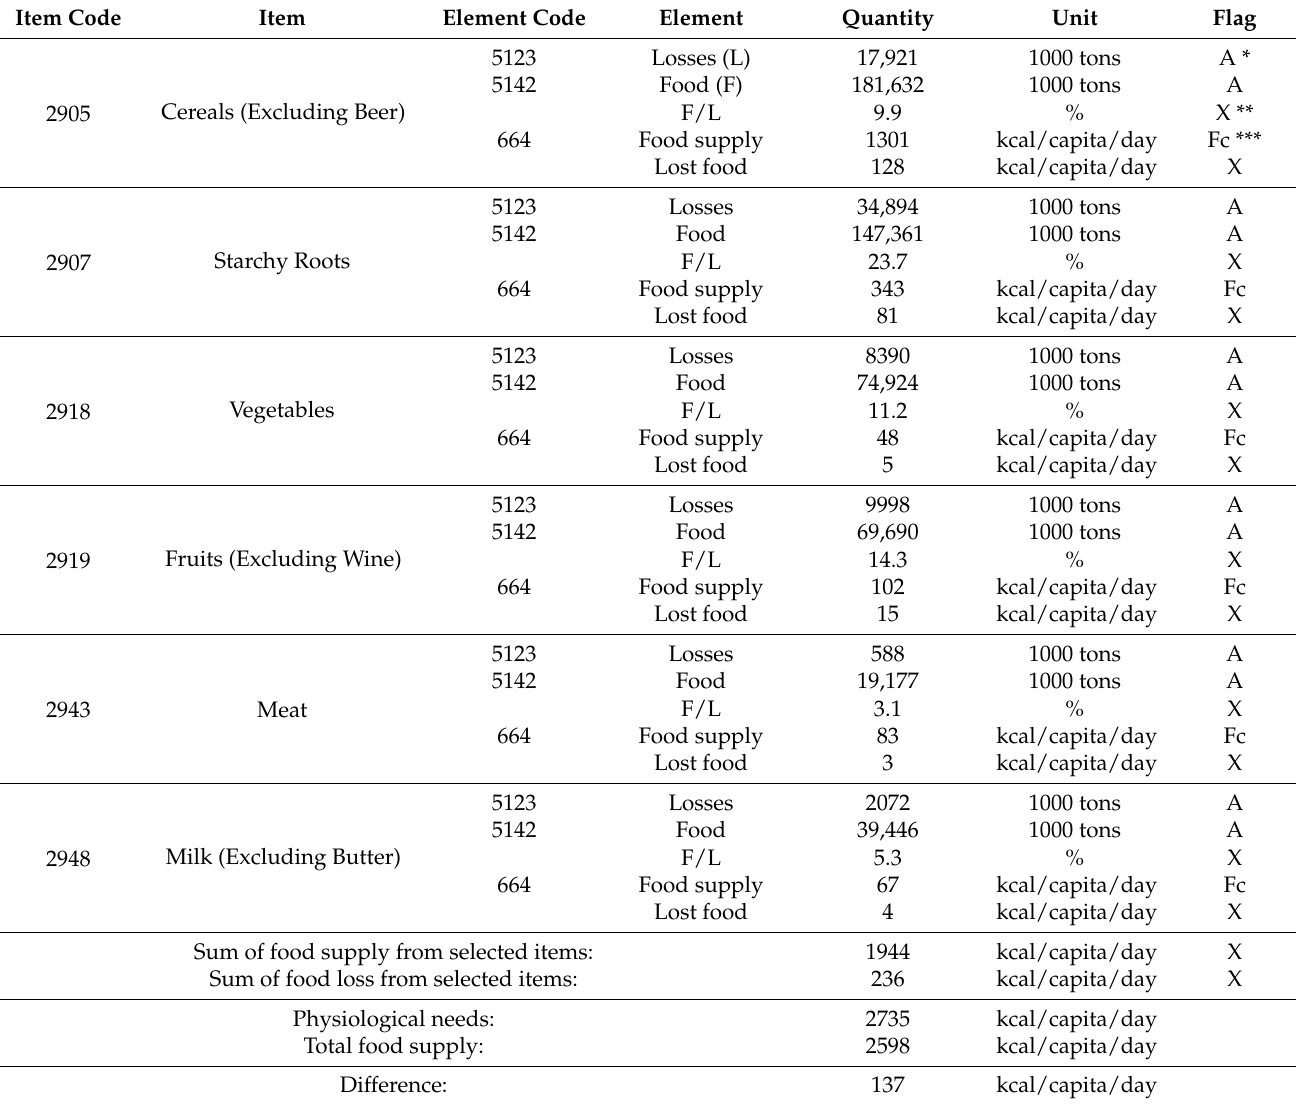
Table 3. Loss and consumption of six different items in Africa, 2017. Data source: FAOSTAT [39], edited by authors. Item